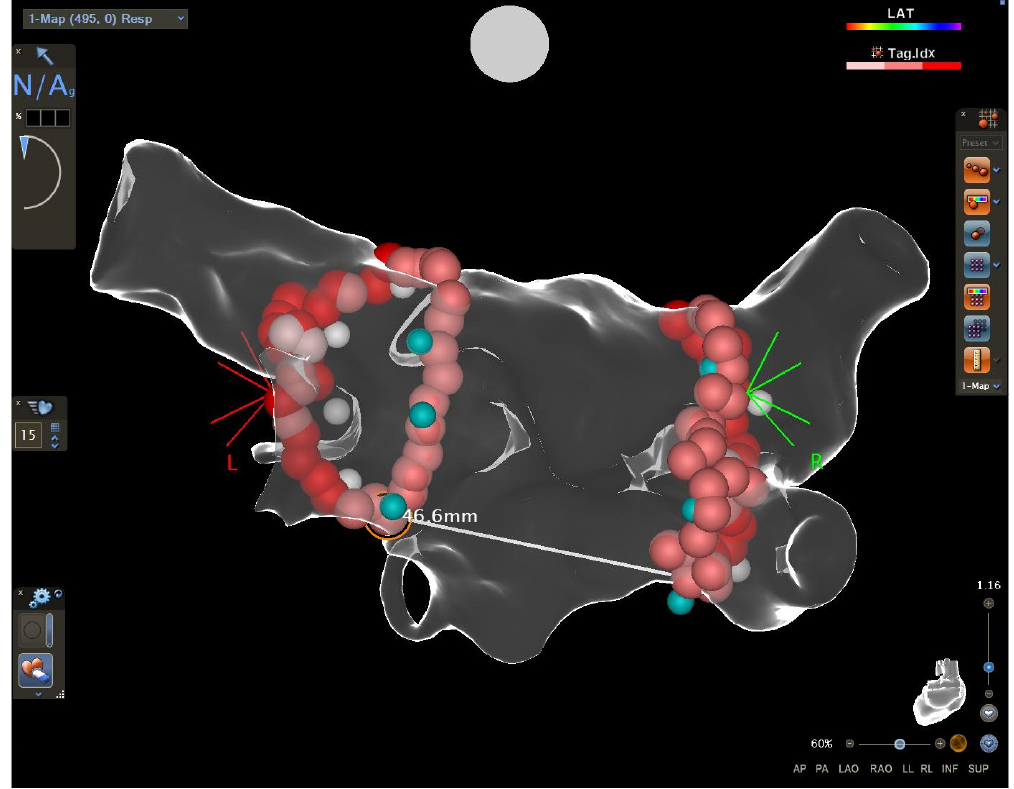
Figure 2. The measurement of the lower distance between the lowest points.